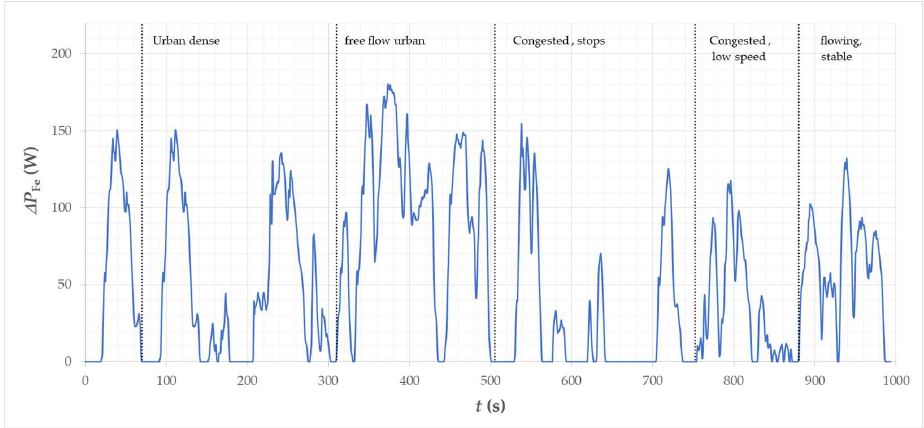
Figure 18. The calculated waveform of loss in the stator core of the motor for the Artemis Urban cycle .